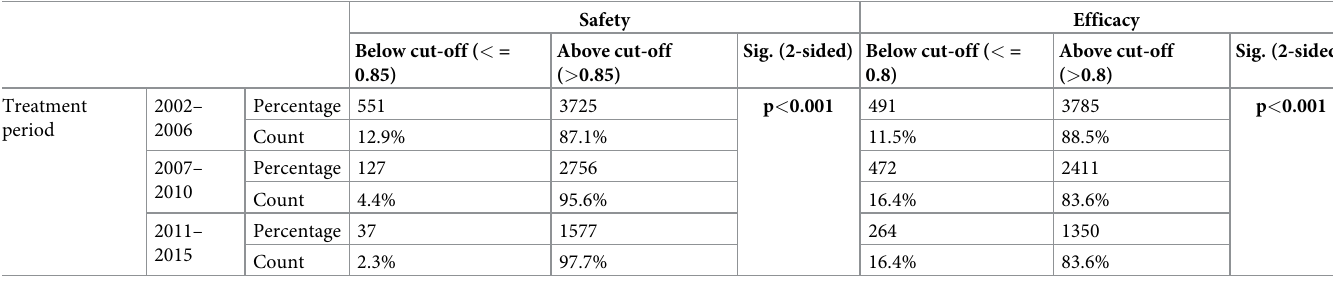
Table 9. Correlation between treatment period and safety and efficacy (Pearson Chi-Square).